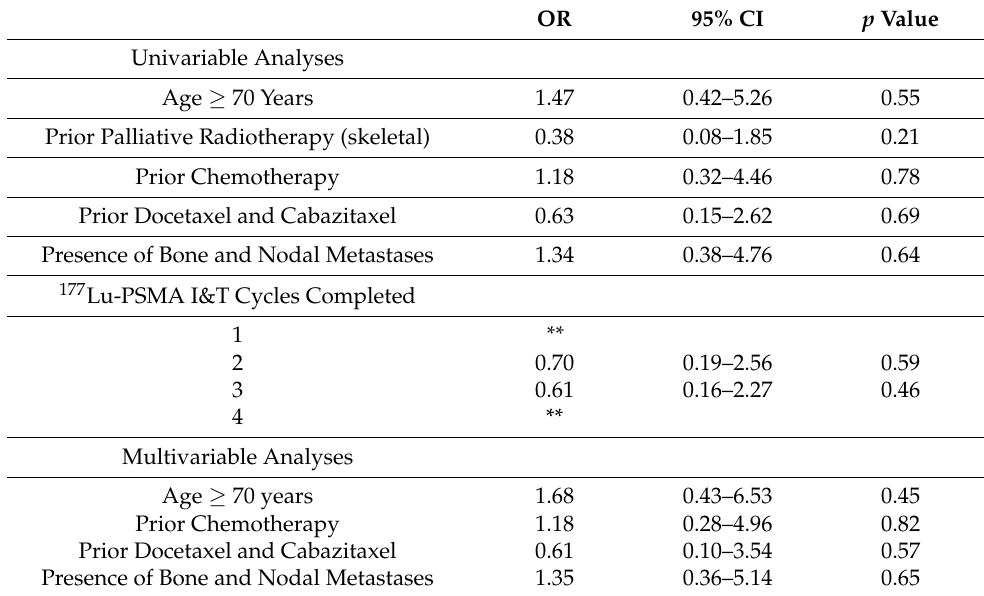
Table 2. Univariable and multivariable analyses of selected risk factors and their odds-ratios for the development of grade ≥ 3 haematologic toxicity following therapy with 177 Lu-PSMA I&T for